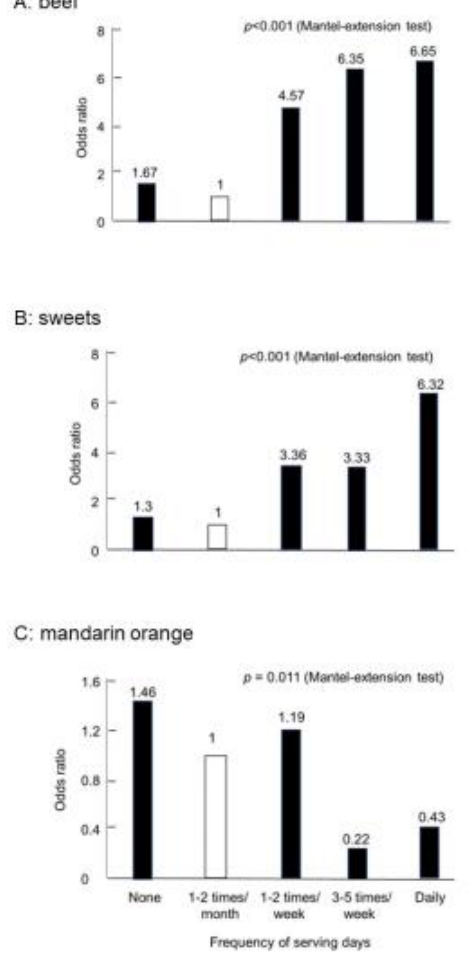
Figure 5. Correlation between Crohn ’ s disease and ulcerative colitis in the annual numbers of new cases in Japan. In Japan, the national registration of ulcerative colitis cases and Crohn ’ s disease cases started in 1975 and 1976, respectively. A scattergram was generated based on data for 24 years from 1977 to 2000. The linear regression formula and correlation coefficient are shown. There are at least two paths from traditional to current global diets. One is where it happens along with economic transition, as observed in developed countries (Figure 6) [25]. The other one is where it occurs along with the development of the food industry, where the population can afford cheap foods in developing or undeveloped countries [26]. As a result, current global consumption consists of an excess of unhealthy foods such as animal fat, animal protein, and sugar and a shortage of healthy foods such as vegetables and fruits [27,28]. This has caused the common diet-related chronic diseases we face: met- abolic syndrome, diabetes mellitus, coronary heart disease, stroke, and non-alcoholic fatty